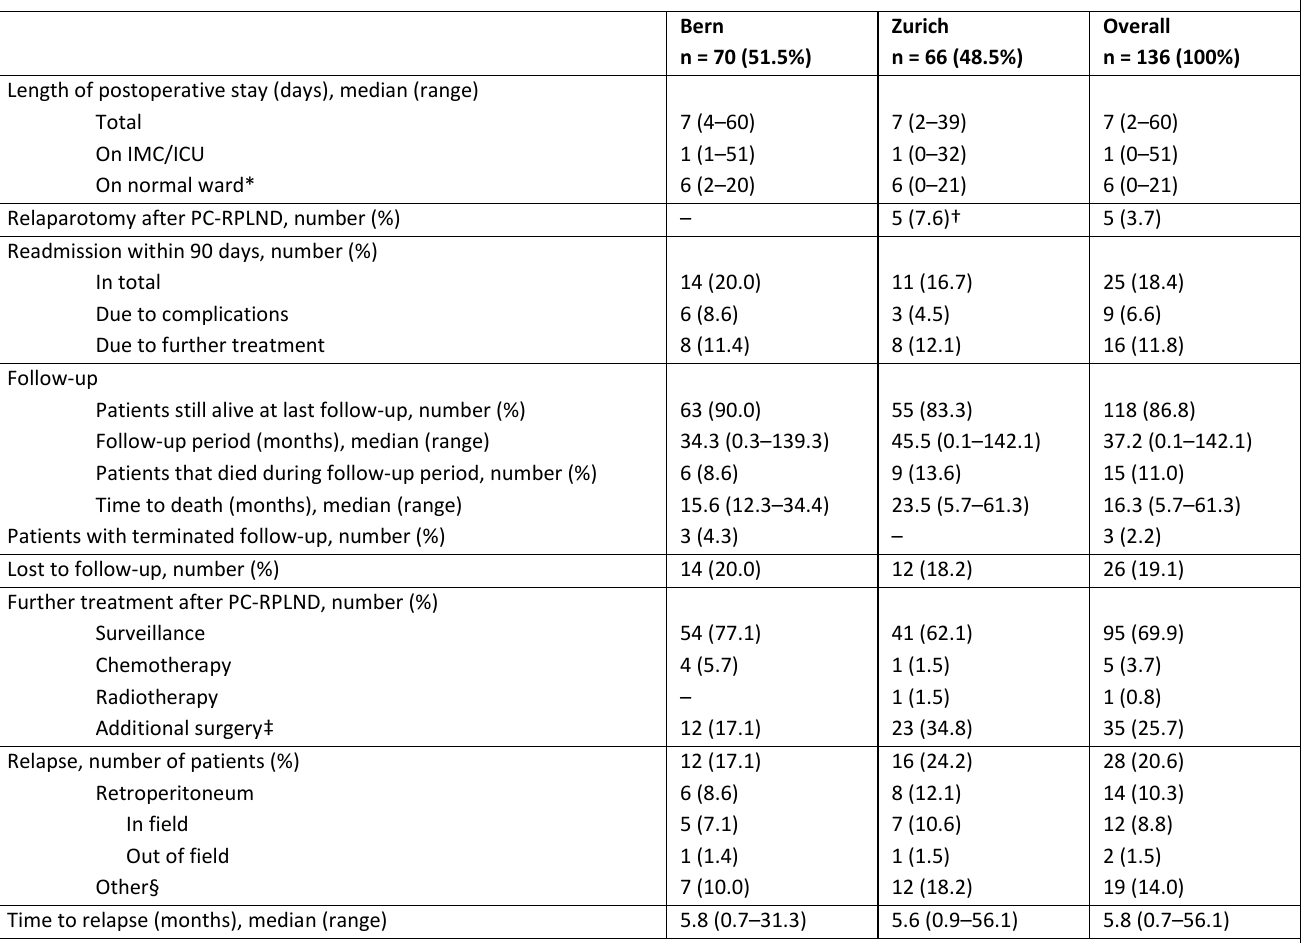
Supplementary table 6. Outcome